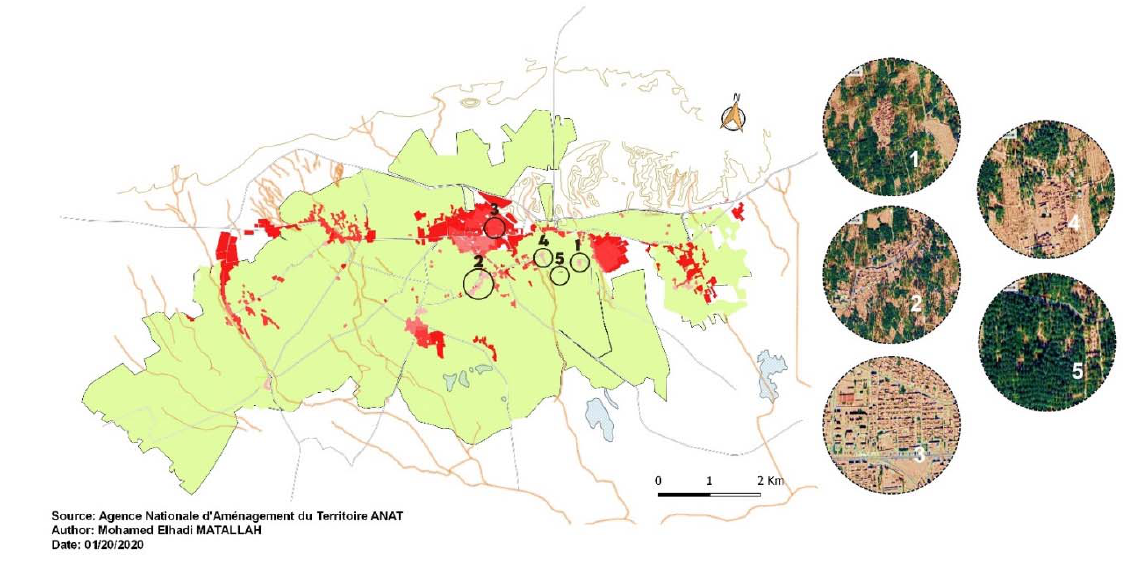
Figure 2. Map of the selected sites in Tolga oasis Complex.